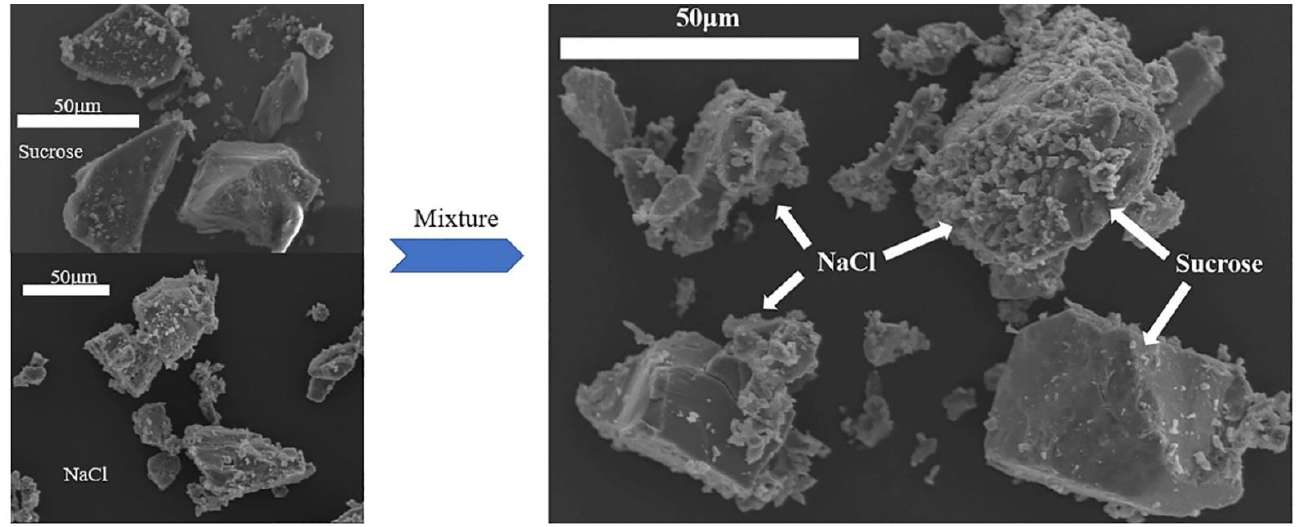
Figure 6. SEM image of NaCl mixed with sucrose dust.